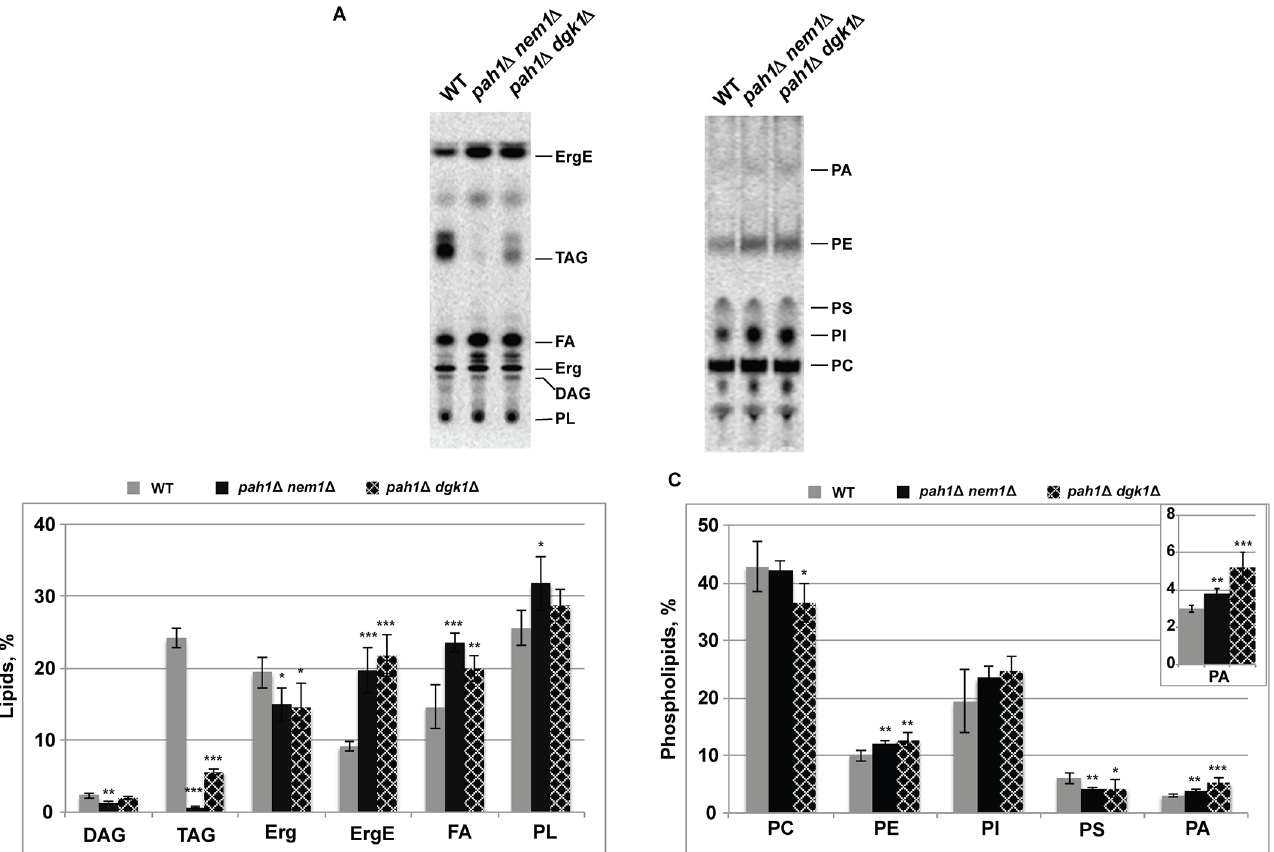
Fig 5. Increased total phospholipid levels in yeast cells lacking PAH1 in the presence of BMV replication. WT, pah1 Δ nem1 Δ and pah1 Δ dgk1 Δ cells with BMV components were grown at 30˚C in SC-Ura-Leu medium in the presence of galactose as the carbon source and [2- 14 C] acetate (1μCi/ml). Lipids were extracted, separated by the one-dimensional thin-layer chromatography system for phospholipids or neutral lipids, visualized by phosphoimaging and analyzed by ImageQuant software. (A) Chromatograms of neutral lipid composition and total phospholipids ( left ),and phospholipid composition ( right ). The chromatograms shown in the panel are representative of three independent experiments. (B) and (C) The mol percentages shown for the individual neutral lipids and phospholipids were normalized to the total 14 C-labeled chloroform fraction, which also contained the unidentified neutral lipids and phospholipids shown in (A). Each data point represents the average of three experiments ± S.D.. (cid:3) , P < 0.05; (cid:3)(cid:3) , P < 0.01; (cid:3)(cid:3)(cid:3) , p < 0.001 (based on single factor ANOVA